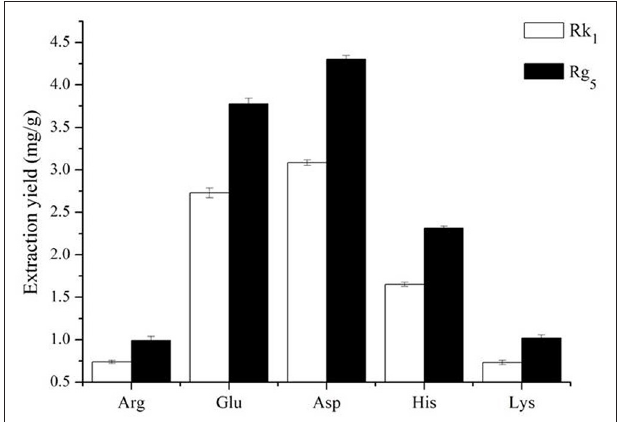
FIGURE 1 | Effect of different amino acids on the contents of ginsenosides Rk 1 and Rg 5 ( n =